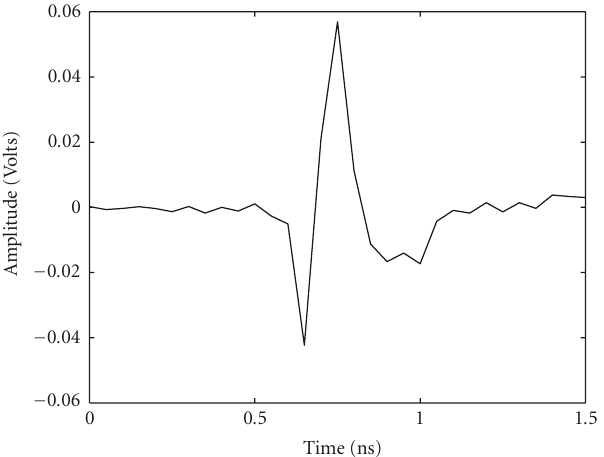
Figure 6: Received UWB signal when receiving antenna is 1 m away from transmitting antenna.